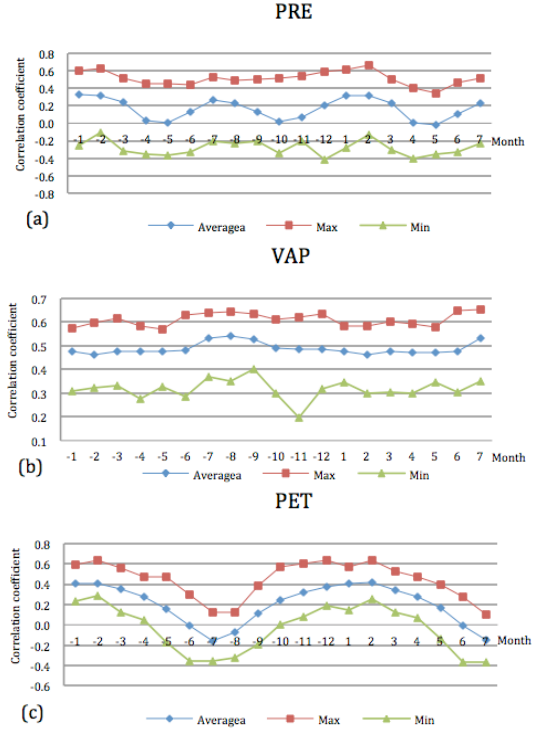
Figure 4. The max (red), mean (blue), and min (green) correlation coefficients for Carolian wren, in terms of (a) PRE, (b) VAP, and (c) PET. The tick labels of x axis from -1 to 7 mean the months from last January to this July for each year.